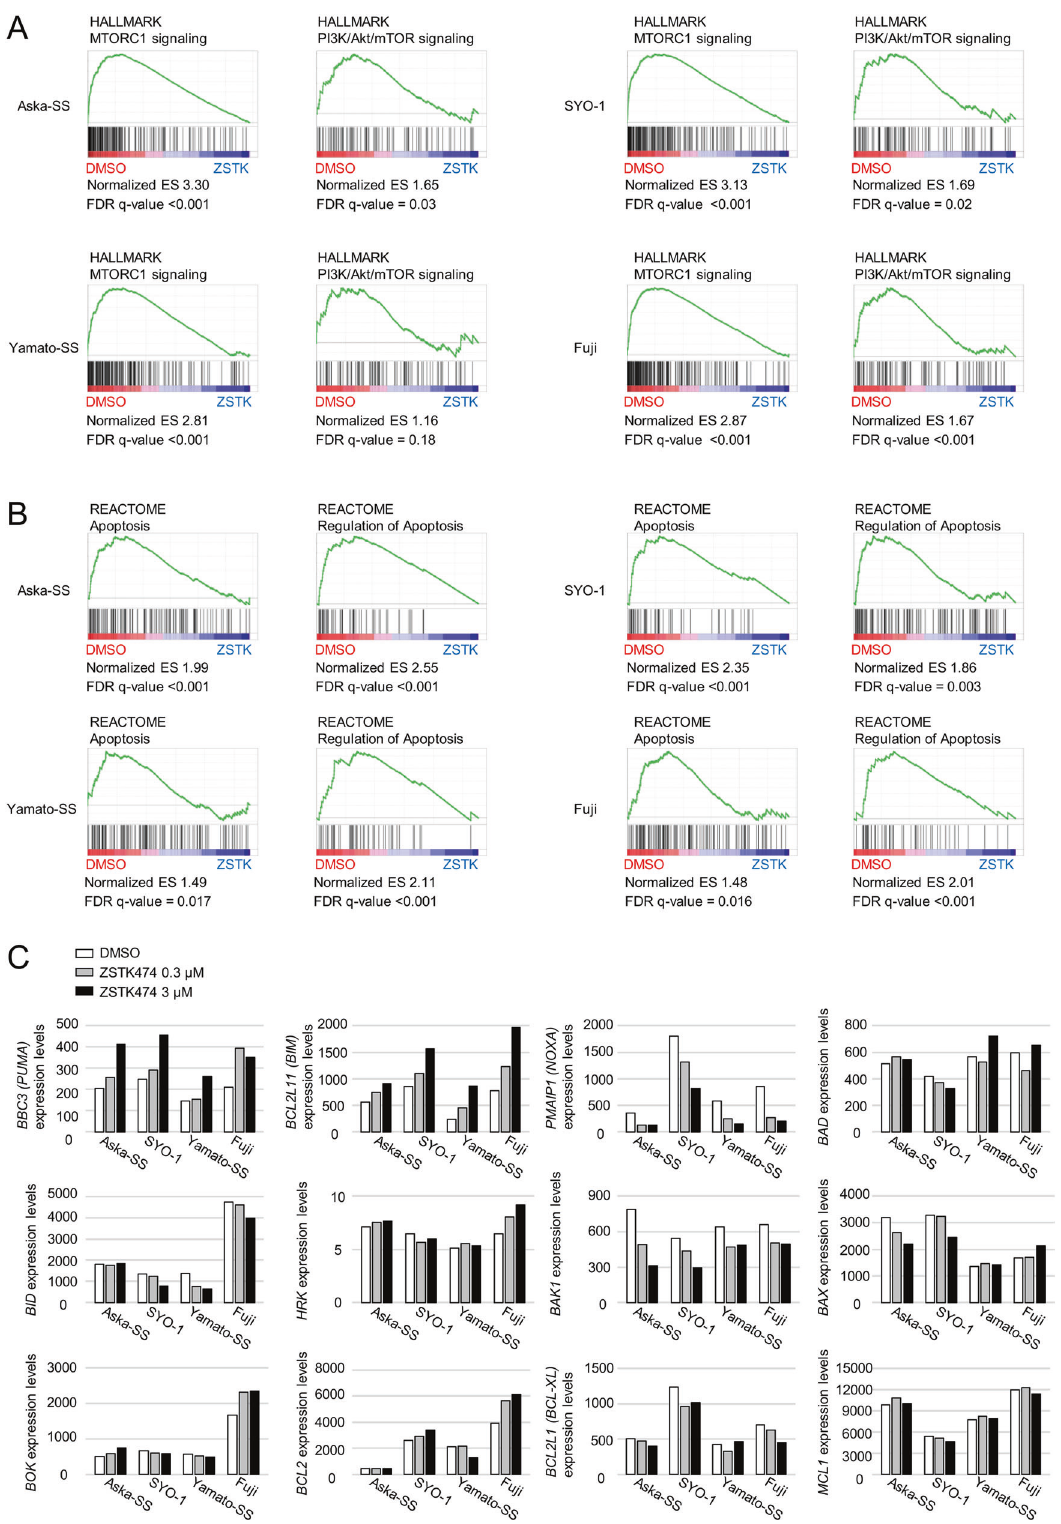
Fig. 3 The treatment of synovial sarcoma cells with PI3K inhibitors inhibited PI3K signaling, induced apoptosis and increased the expression of PUMA and BIM in comprehensive gene expression analysis. Aska-SS, SYO-1 Yamato-SS and Fuji cells were treated with the PI3K inhibitor ZSTK474 at 3 μ M for 24 h and subjected to microarray analysis. A , B Representative GSEA plots showing enrichment for the gene signature associated with PI3K signaling ( A ) and apoptosis ( B ) in the indicated cell lines treated with and without ZSTK474. C Microarray expression data of BCL-2 family genes in Aska-SS, SYO-1 Yamato-SS and Fuji cells treated with ZSTK474 at the indicated concentrations for 24